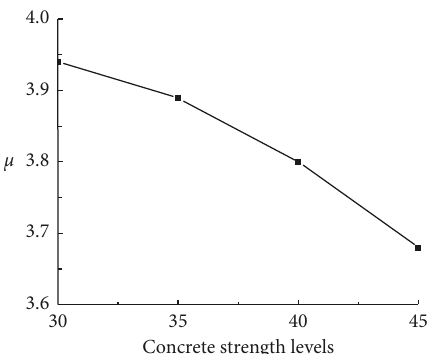
Figure 9: Relationship between various concrete strength levels and ductility coefficients.